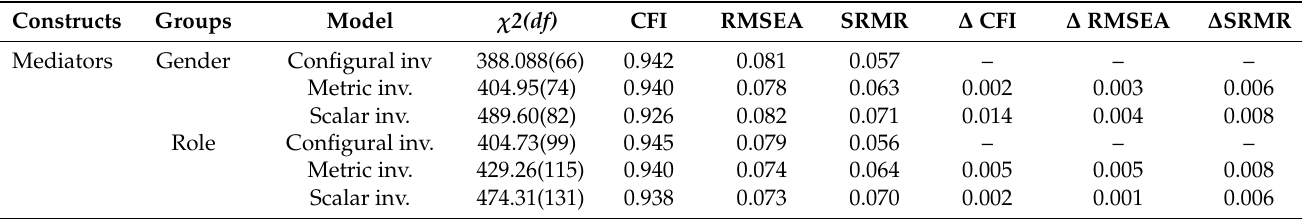
Table 7. Results of invariance analyses for mediators and each output construct across gender (male, female) and across academic role (researcher, associate professor, full